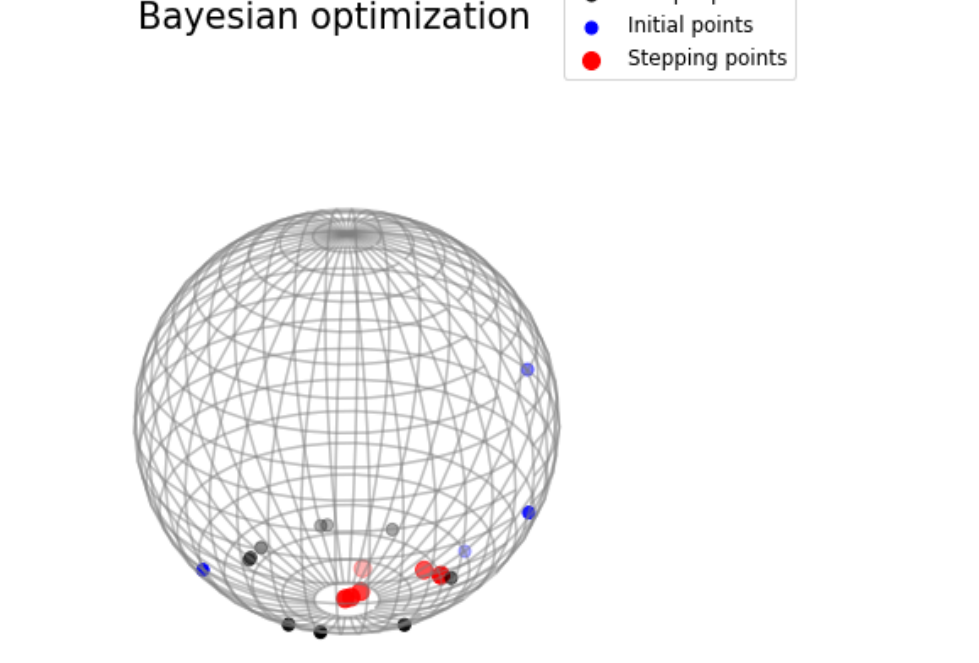
Figure 2. The iteration steps of the eBO method on the sphere S 2 . The data points x 1 ,..., x n are plotted as those black points on the same latitude of the sphere. The true extrinsic mean is the south pole ( 0,0, − 1 ) . We start with those random blue points on the sphere. The outputs of iterations in our Algorithm 1 are marked as red points on the sphere, converging to the ground truth.